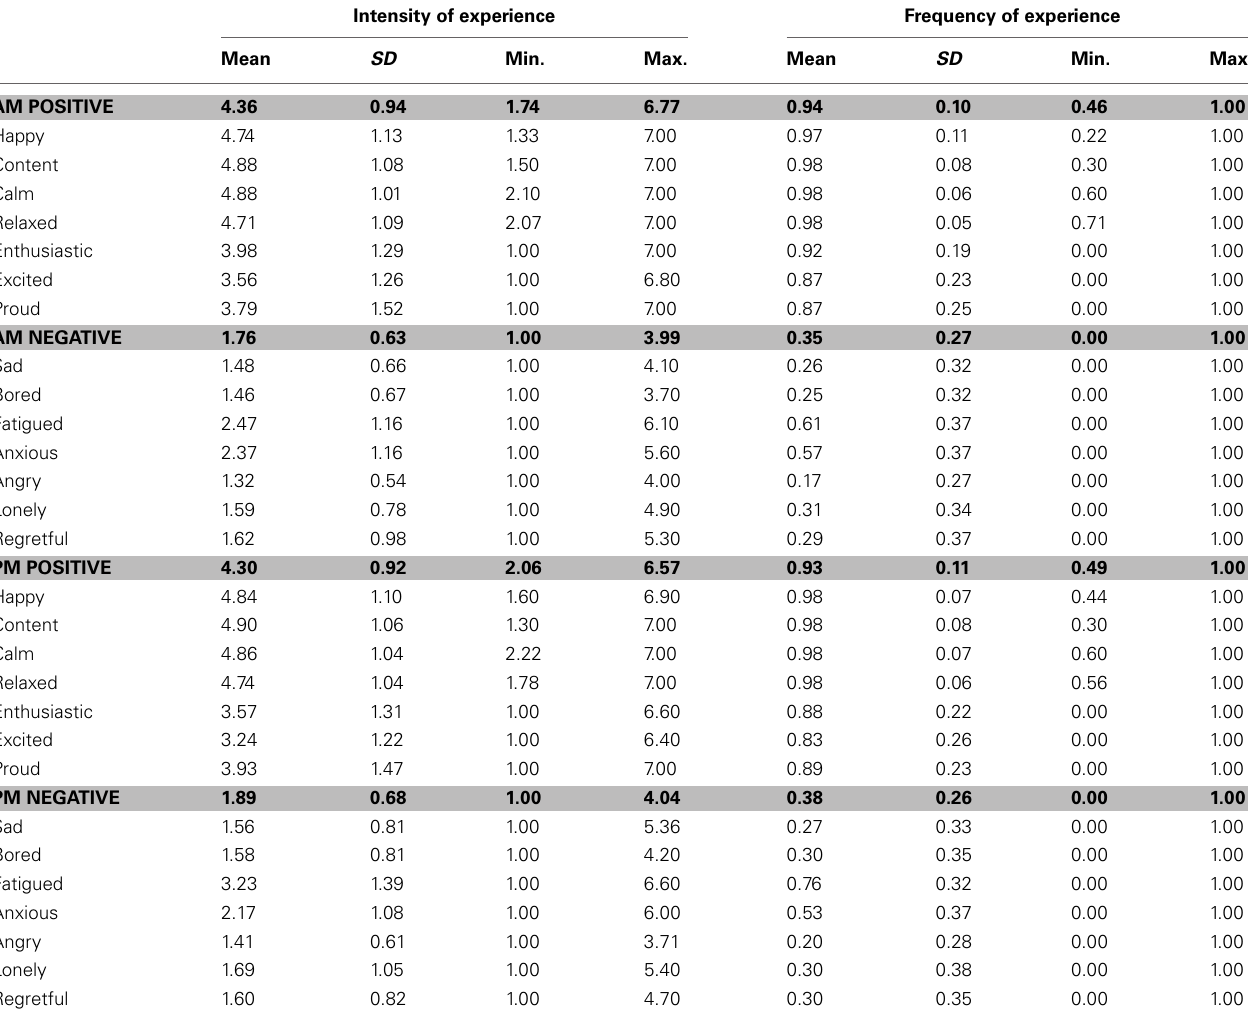
Table 1 | Descriptive statistics for emotional experience in the morning and the evening. Intensity of experience Frequency of experience Mean SD